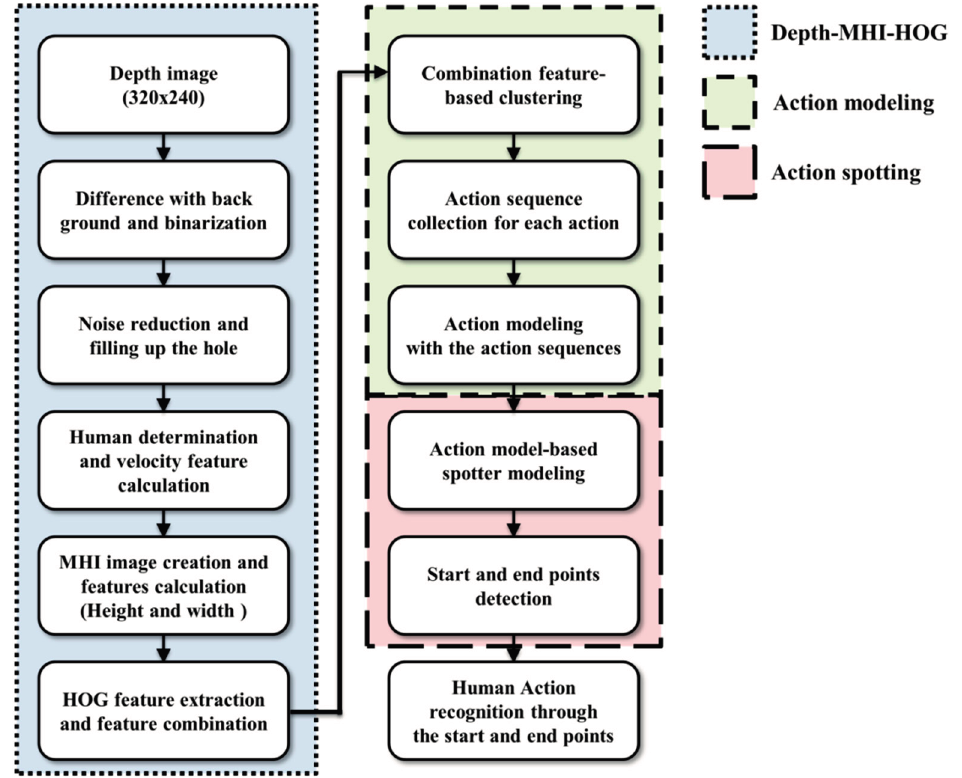
Figure 2. Block diagram of system for human action spotting and